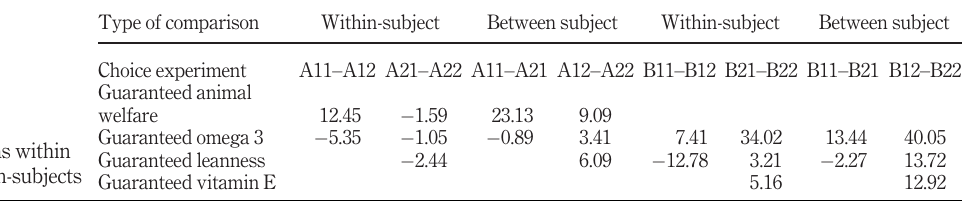
Type of comparison